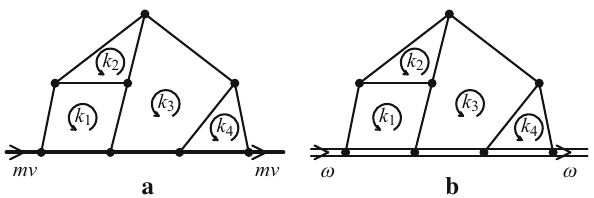
Fig. 1 Diagrams producing the highest degree of n f in each order of perturbation theory current renormalization constant Dirac structure and is a function of the Minkowski angle ϑ : · v = cosh ϑ = w . v 1 2